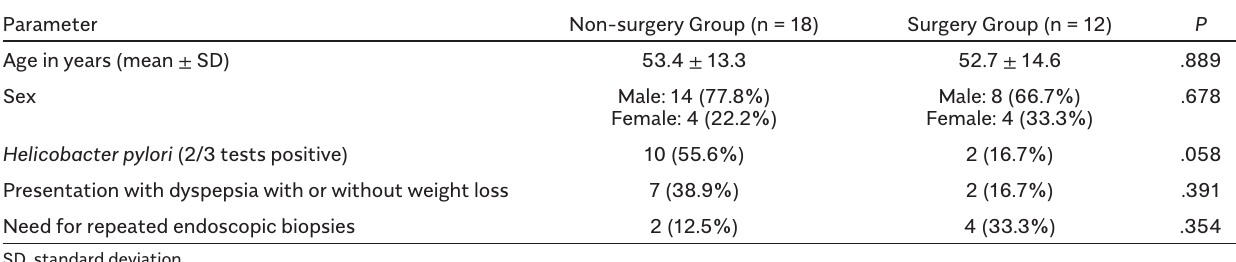
Table 1. Comparison of Demographic and Clinical Characteristics of Non-Surgery and Surgery Groups